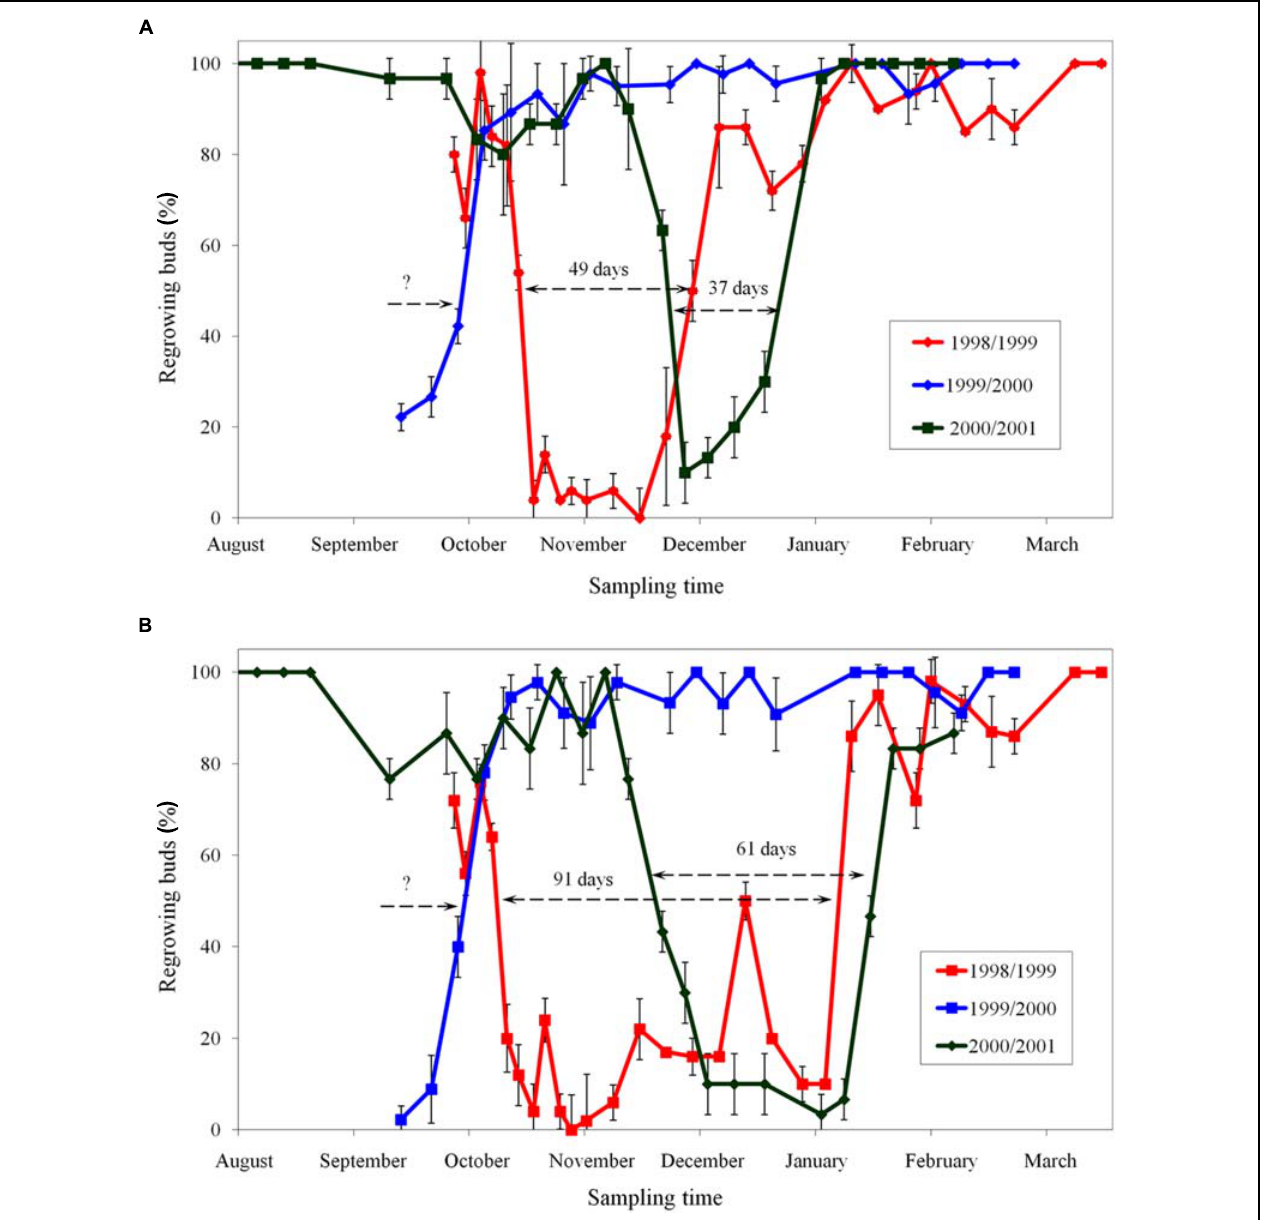
FIGURE 2 | Period of endodormancy of vegetative buds of apple cultivars ‘Sampion’ (A) and ‘Spartan’ (B) in the seasons of 1998/1999, 1999/2000, and 2000/2001. Endodormancy was assessed when less than 50% of buds did not regrow after 30 days in growth inductive conditions. Bars indicate SD ( p < 0.05). Note: Different beginning and the end of endodormancy. The length of arrows corresponds to the length of endodormancy (in days). The question mark indicates unknown length of endodormancy in the season